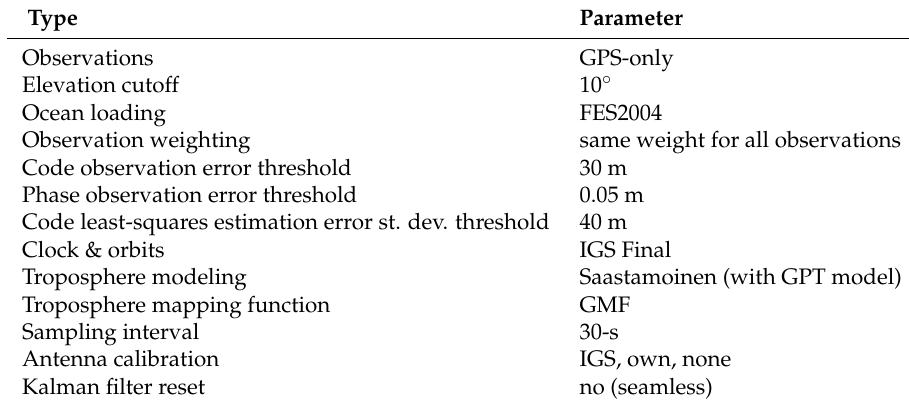
Table 3. goGPS settings for Precise Point Positioning (PPP) ZTD